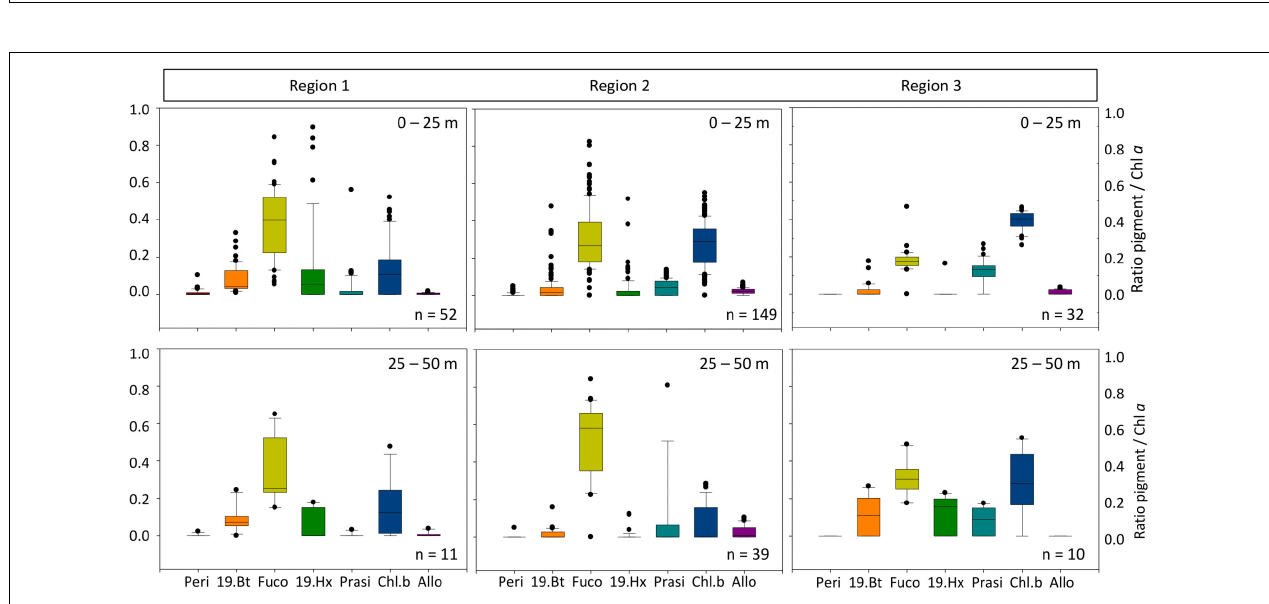
FIGURE 3 | Marker pigment ratio to chlorophyll a for the various regions (upper panel 0–25 m; lower panel 25–50 m). Peri, Peridinin; 19.Bt, 19-butanoyloxyfucoxanthin; Fuco, fucoxanthin; 19.Hx, 19-Hexanoyloxyfucoxanthin; Prasi, Prasinoxanthin; Chl. b , Chlorophyll b ; Allo, Alloxanthin indicative for Dinoflagellates, Crysophytes, Diatoms, Prymnesiophytes, Prasinophytes, Chlorophytes, and Cryptophytes, respectively.